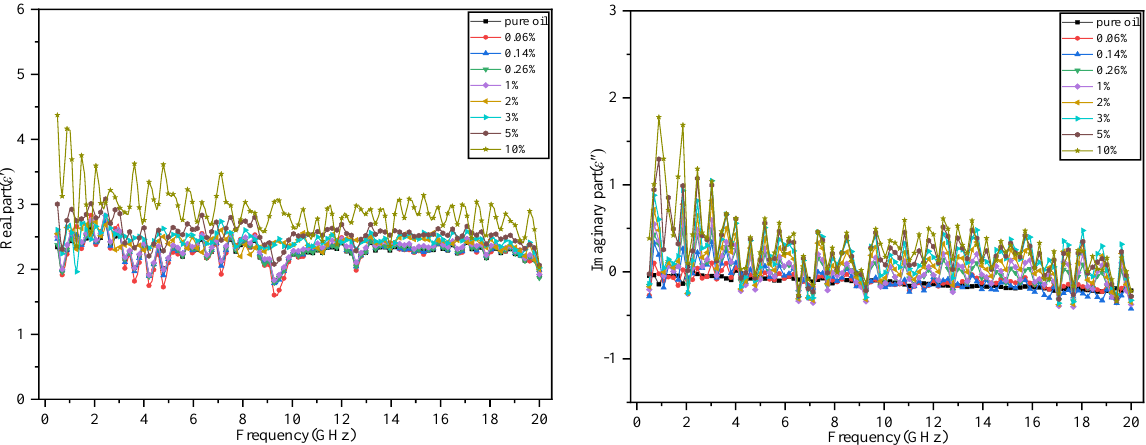
Figure 3. Experimental flowchart. A vector network analyzer (E5071C) with an emulsion dielectric test probe (N1501A) and an ultrasonic crusher are the main equipment used in this experiment. The vector network analyzer uses a probe to measure the complex dielectric constant of a polymer emulsion. The ultrasonic crusher is used to shock the oil–water polymer emulsion by ultrasonic waves in order to fully mix the emulsion. The experimental temperature was maintained at 23.5 °C, and the pressure was maintained at 1 atm. The measuring frequency range of the instrument was set to 500 MHz – 20 GHz, and a vector network analyzer with a dielectric probe was used to measure the complex dielectric constant of the polymer emulsion under different moisture contents. The measurement results are shown in Figure 4.